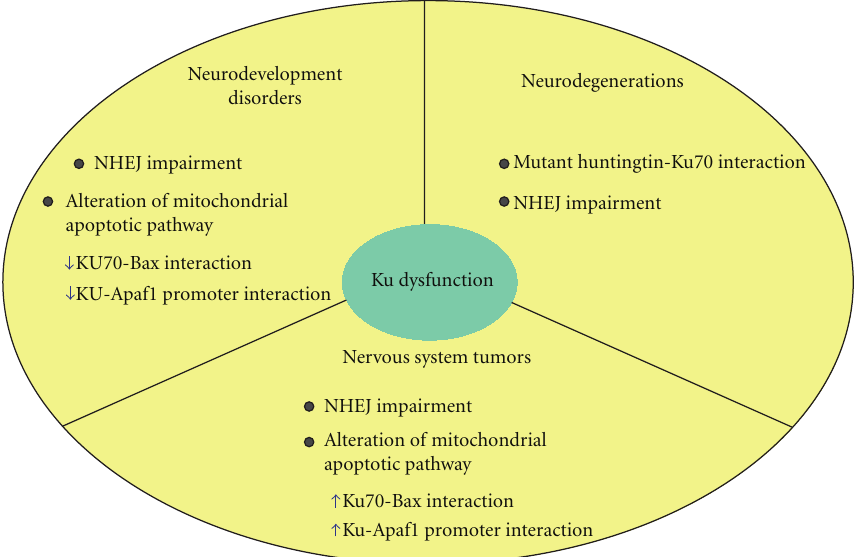
Figure 2: Ku dysfunction can lead to pathological states of the nervous system. Besides NHEJ impairment, which results in DNA damage accumulation, Ku-related alterations of the mitochondrial apoptotic pathway can play a crucial role in neurodevelopment disorders and neoplastic transformations. In particular, Bax-Ku70 and/or Apaf1 promoter-Ku interaction can be decreased and lead to massive apoptosis upon Ku loss of function, as observable in Ku-related disorders of neurodevelopment. Alternatively, Ku gain of function in tumors of the nervous system may lead to an increase of Ku binding to Bax and/or the Apaf1 promoter, thus leading to evade apoptosis and to increase chemoresistance. On the other hand, in a mature nervous system, Ku sequestration mediated by mutant huntingtin can contribute to the HD pathology, by leading to an altered DSBs repair by